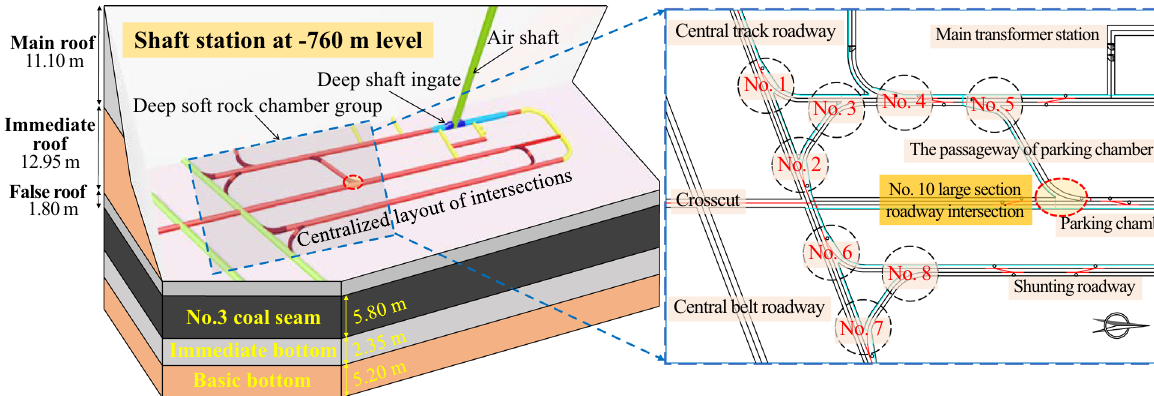
Fig. 2 Location map of all roadway intersections